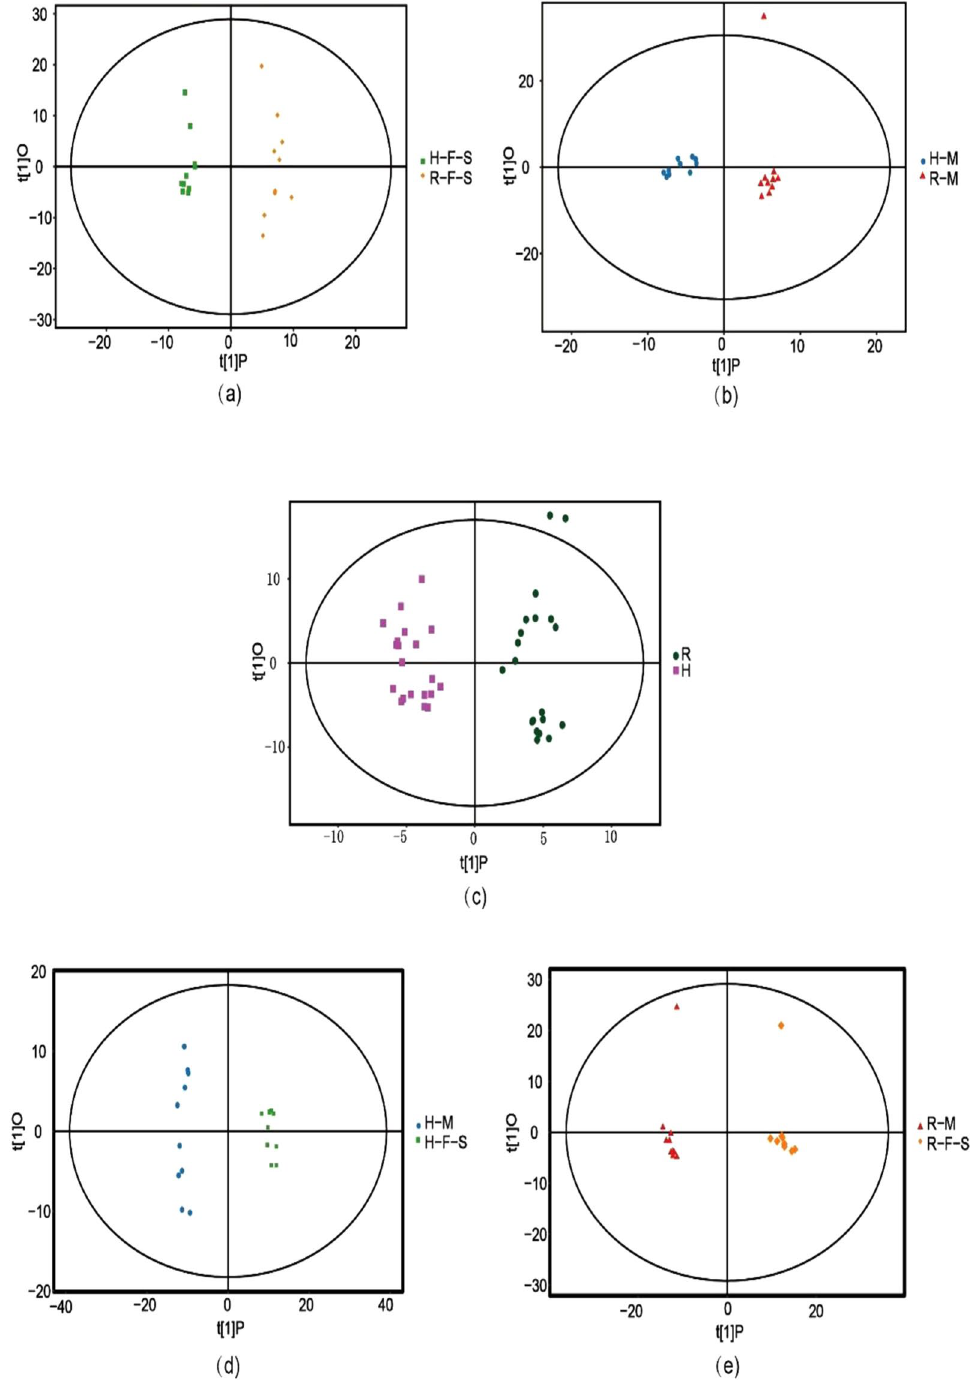
Figure 2. Score scatter plot of OPLS-DA model for different pairwise comparisons: ( a ) H-F-S vs. R-F-S, ( b ) H-M vs. R-M, ( c ) H vs. R, ( d ) H-F-S vs. H-M, and ( e ) R-F-S vs.